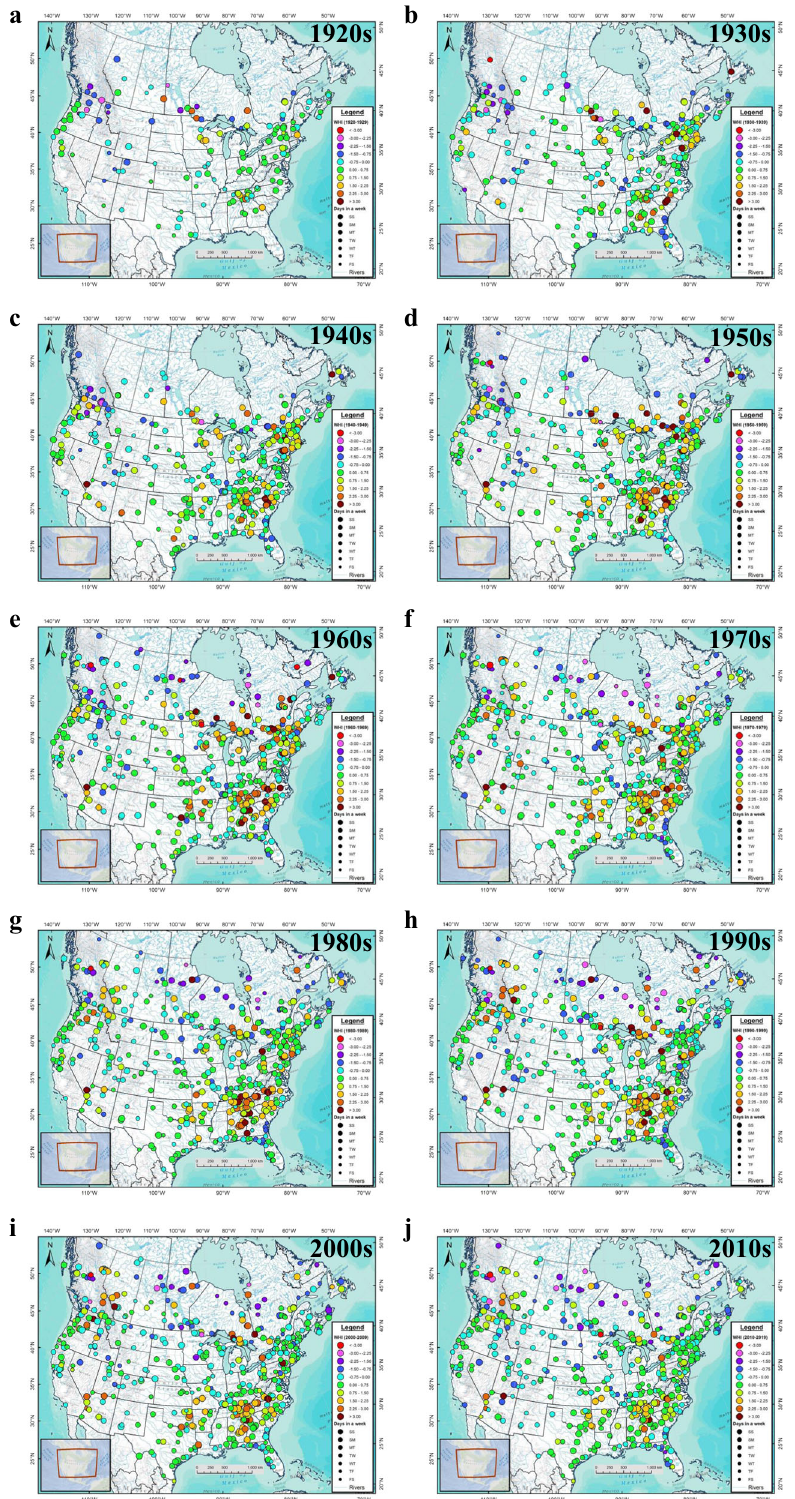
Fig. 4 Maps of the decadal mean WHI values for 500 sites across the USA and Canada. Maps are shown for ( a ) 1920 – 1929, ( b ) 1930 – 1939, ( c ) 1940 – 1949, ( d ) 1950 – 1959, ( e ) 1960 – 1969, ( f ) 1970 – 1979, ( g ) 1980 – 1989, ( h ) 1990 – 1999, ( i ) 2000 – 2009, and ( j ) 2010 – 2019. Circle size corresponds to the two consecutive days with low fl ows beginning with the Saturday/Sunday (SS, largest symbols) combination and ending with the Friday/Saturday (FS, smallest symbols). Results are shown only when n y ≥ 5 years in a given